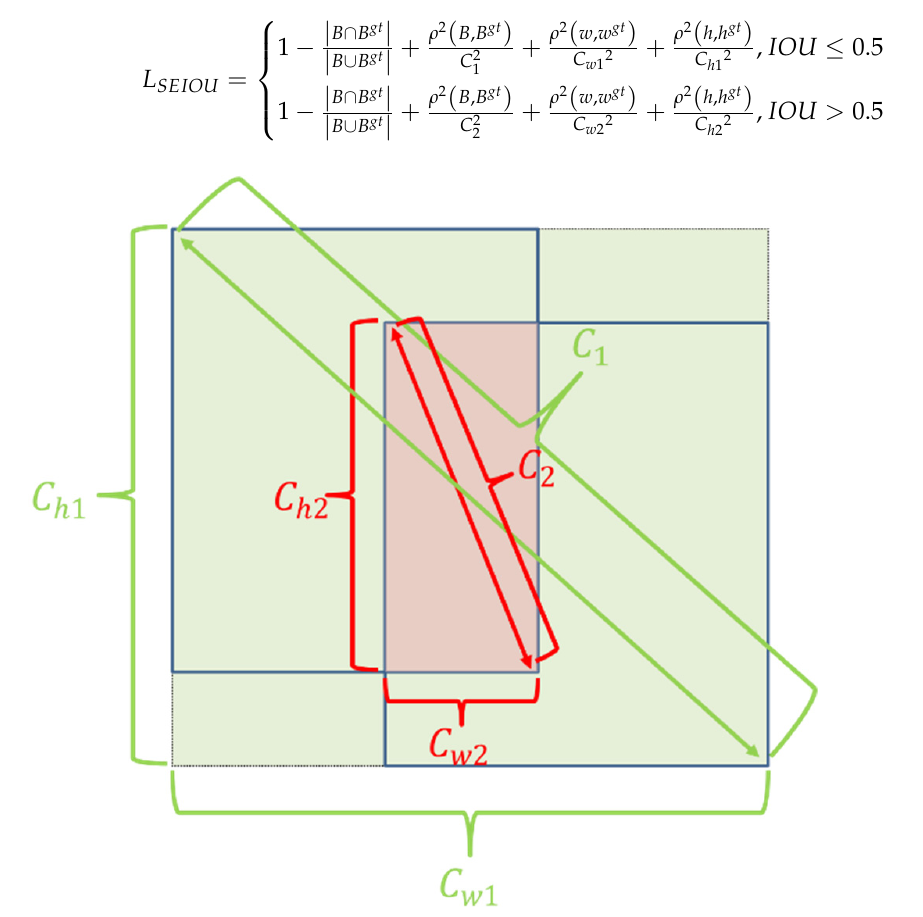
Figure 4. Differences between EIOU (green) and our method (both green and red).